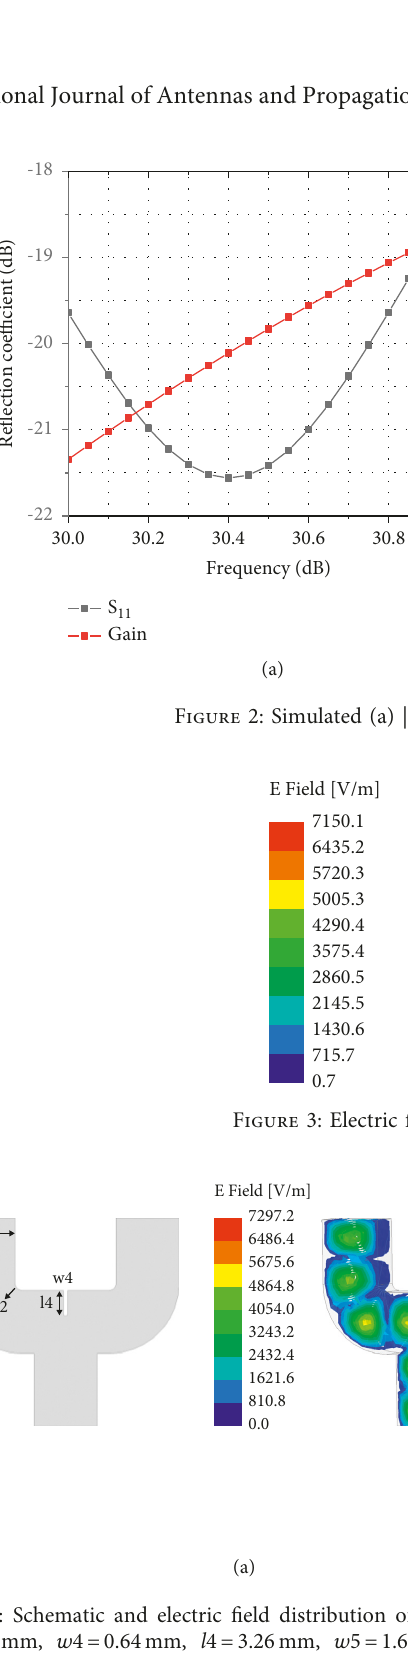
0.64mm, l 4 (cid:29)